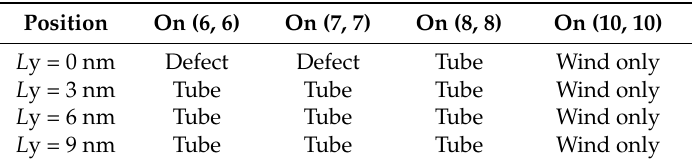
Table 1. Final states of the BP with 4 types of CNTs at different initial positions along the y-direction with α = 0 ◦ at 14 K. “Tube” means the BP ribbon forms into an ideal tube. “Defect” means the BP nanotube has a defect. “Wind only” represents the ribbon just winds upon the CNT, but does not form into a tube.